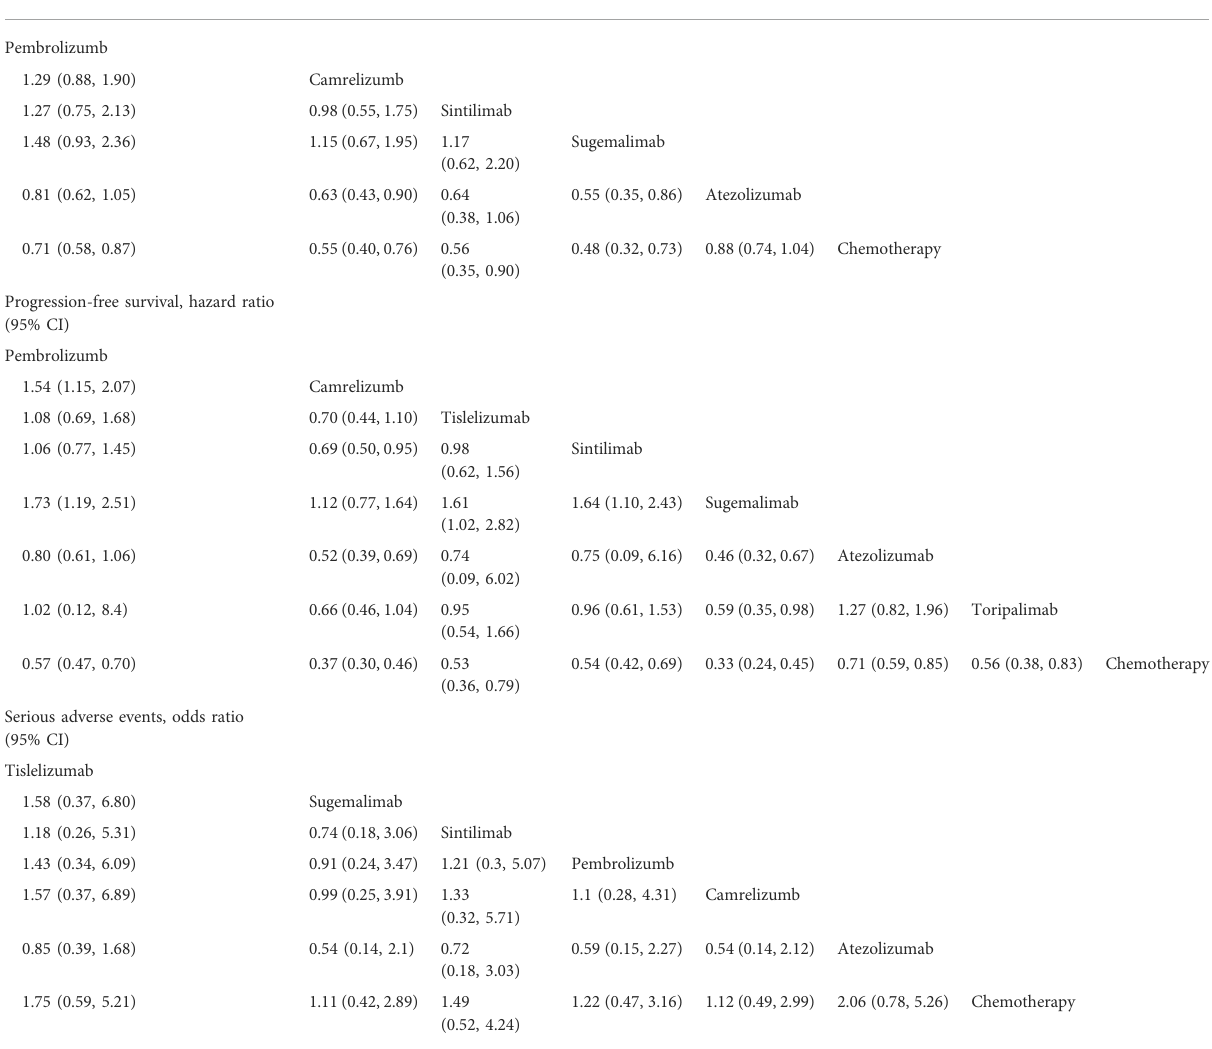
TABLE 3 Relative effect estimates for all possible pairwise treatment comparisons for overall survival, progression-free survival. Overall survival, hazard ratio (95%